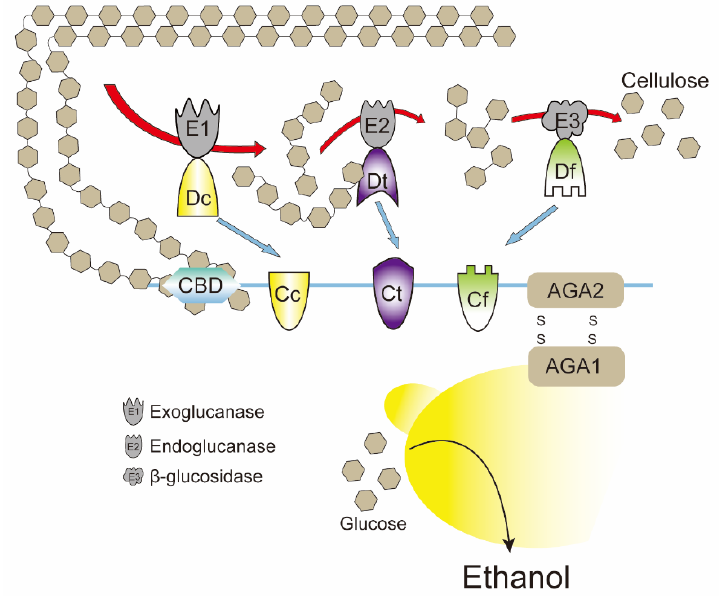
Figure 3. Schematic of minicellulosome assembly on the cell surface. A trifunctional scaffoldin consisting of an internal CBD (cellulose binding domain) flanked by three divergent cohesion domains is displayed on the yeast cell surface. E. coli cell lysates containing endoglucanase, exoglucanase, and beta-glucosidase fused with corresponding dockerin domains are mixed with engineering yeast cells for minicellulosome assembly. AGA1/2: GPI anchor; Cc: cohesion domain from C. cellulolyticum ; Dc: dockerin domain from C. cellulolyticum ; Ct: cohesion domain from C. thermocellum; Dt: dockerin domain from C. thermocellum; Cf: cohesion domain from R. flavefaciens ; Df: dockerin domain from R. flavefaciens.